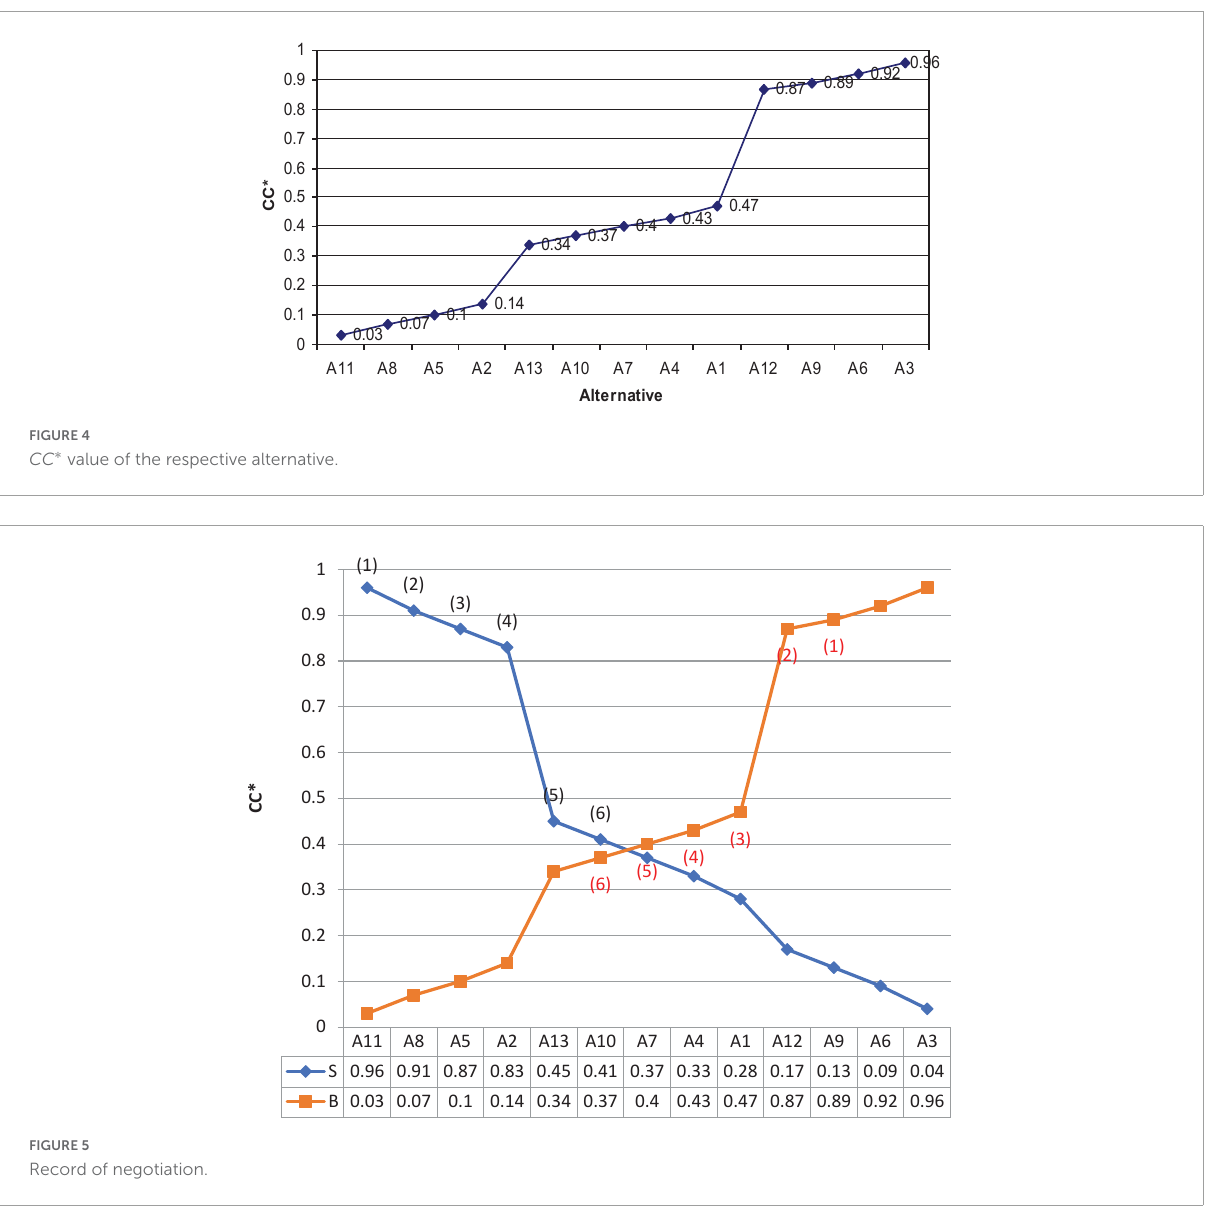
TABLE 11 Preparation of strategy, tactic, and concession methods.